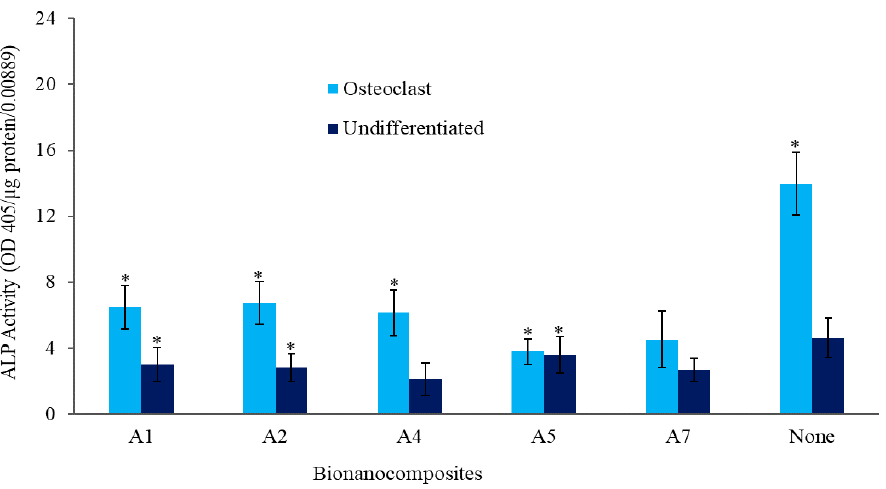
Figure 6. TRAP expression of raw cells in bionanocomposites with 75% porosity. * represents p < 0.05.